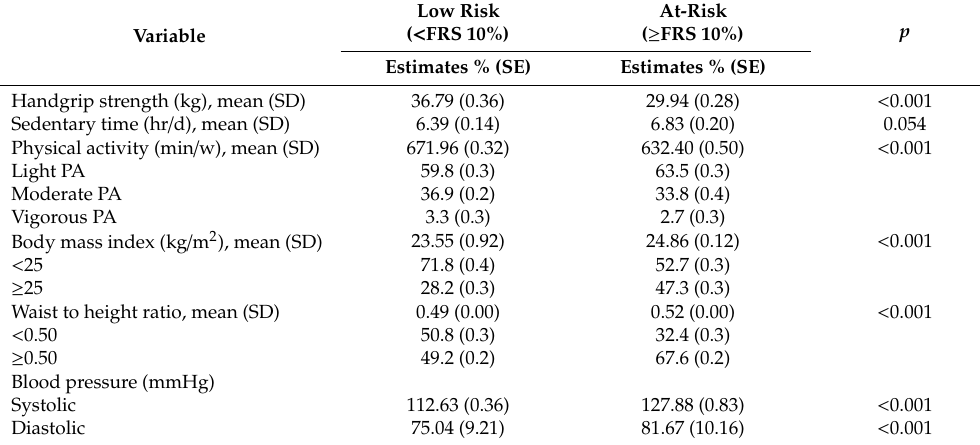
Table 2. Clinical characteristics and biomarkers of the subjects by